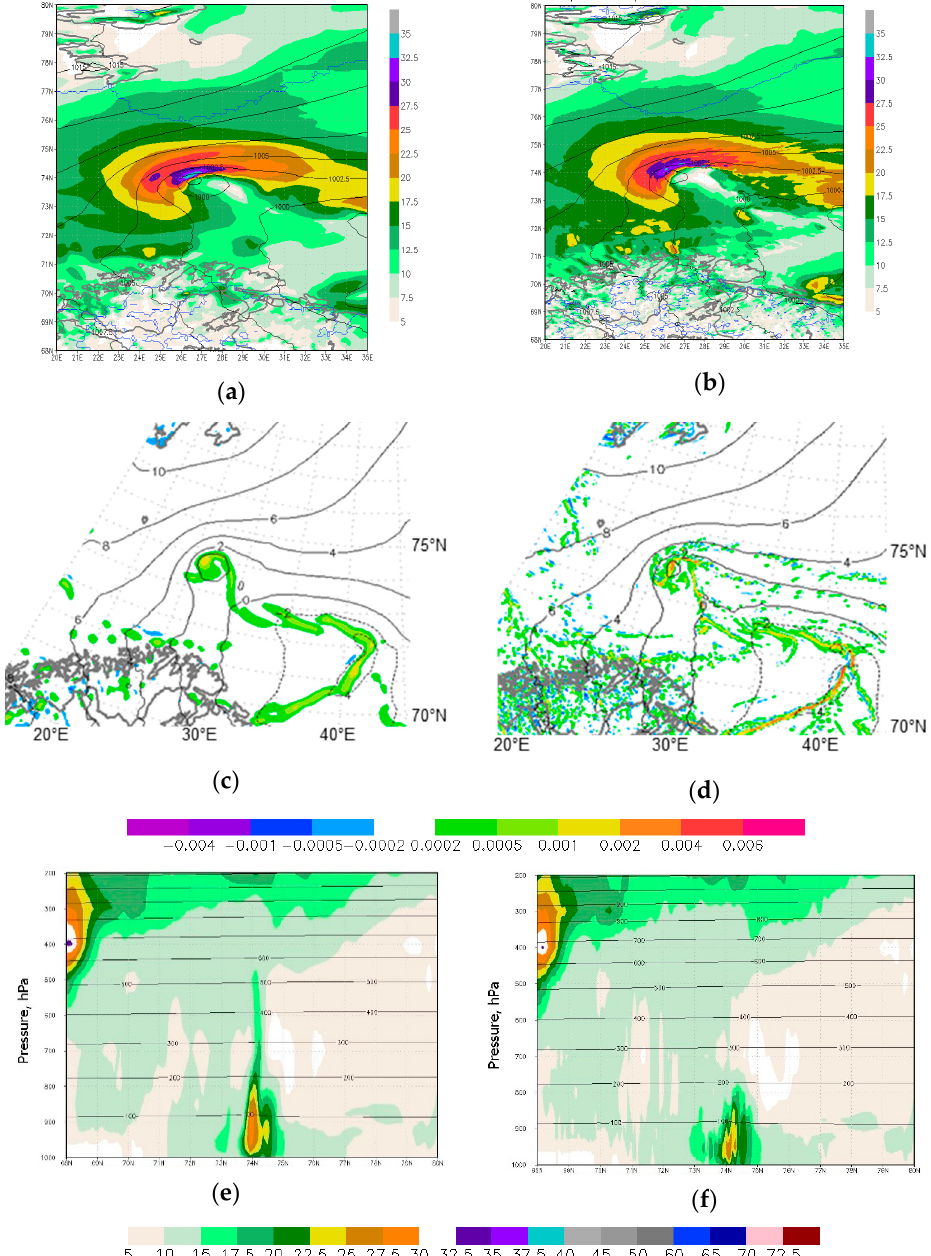
Figure 8. ICON-A6.5 (left), ICON-A2 (right): wind gust (m/s) and sea-level pressure (hPa) ( a , b ); relative vorticity (1/s) at Figure 8. ICON ‐ A6.5 (left), ICON ‐ A2 (right): wind gust (m/s) and sea ‐ level pressure (hPa) ( a , b ); relative vorticity (1/s) at 1000 hPa ( c , d ); wind profile along 26 ◦ E up to 200 hPa ( e , f ); valid time 18:00 UTC 26 November 1000 hPa ( c , d ); wind profile along 26 ̊ E up to 200 hPa ( e , f ); valid time 18:00 UTC 26 November 2019.